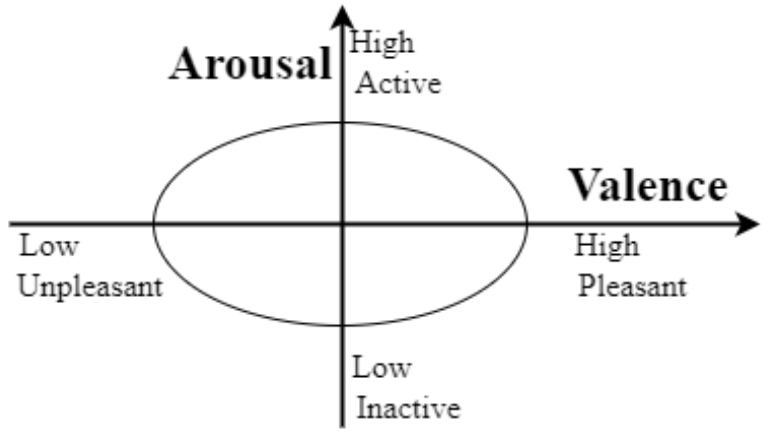
Figure 2. The plane’s horizontal axis is depicted by valence ranging from unpleasant to pleasant, and its vertical axis is depicted by arousal, which indicates the activation or energy level of the emotion. Therefore, this paper proposes a music emotion representation model and an emotion state representation model based on the emotion valence-arousal model.